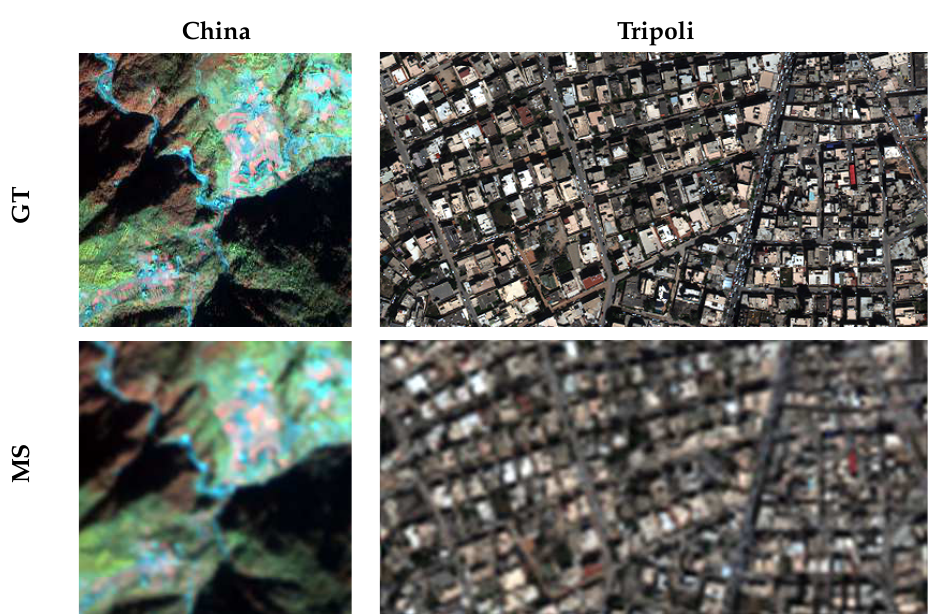
Figure 3. Reduced resolution datasets: China dataset (on the left), Tripoli dataset (on the right). The first row reports the original MS image (used as the ground-truth) and the second row reports the degraded MS image, upsampled to the ground-truth